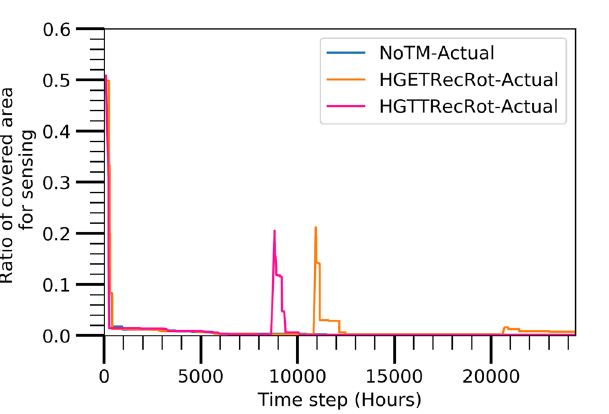
Figure 10. Actual evaluated covered sensing